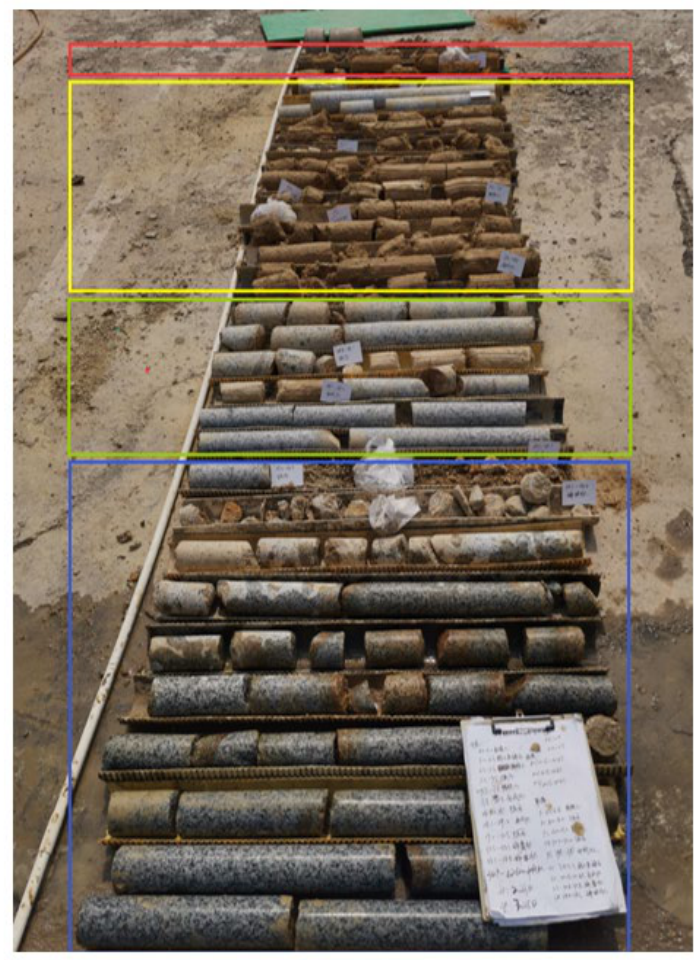
Figure 17. Core sample photos of borehole.